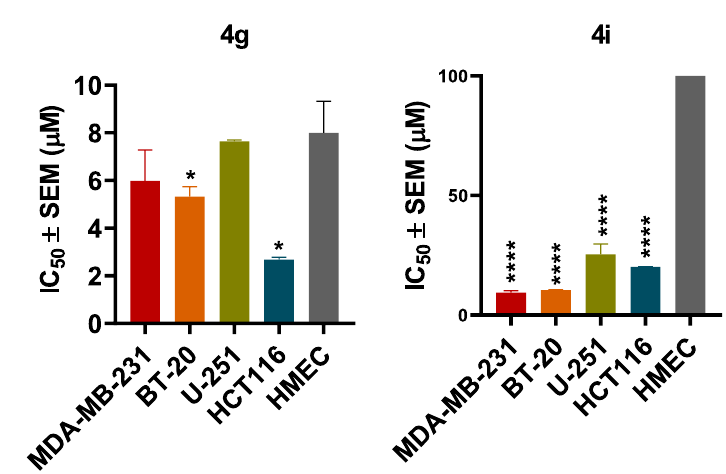
Figure 2. The efficacy and selectivity of 4g and 4i in MDA-MB-231, BT-20, U-251, and HCT116, and compared to the normal cell line, HMEC ( A ) the viability curves for cancer cells (MDA-MB-231, BT-20, U-251, HCT116), and the normal cell line, HMEC; ( B ) the IC 50 values of 4g and 4i for these cell lines are also compared to the normal cell line. Cell survival was determined using the 3-(4,5-dimethylthiazol-2yl)-2,5-diphenyltetrazolium bromide (MTT) assay. The IC 50 values are represented as the means ± SD of three independent experiments performed in triplicate with * p < 0.05, **** p < 0.0001 vs. control group. Table 3. The effects of the chrysin-like compounds ( 4a – 4o ) on the survival of cancer cell lines (breast, glioblastoma, and colon) and a normal non-cancerous cell line (normal human mammary epithelial cells) . Compound Breast Cancer Brain Cancer Colon Cancer Normal Cells